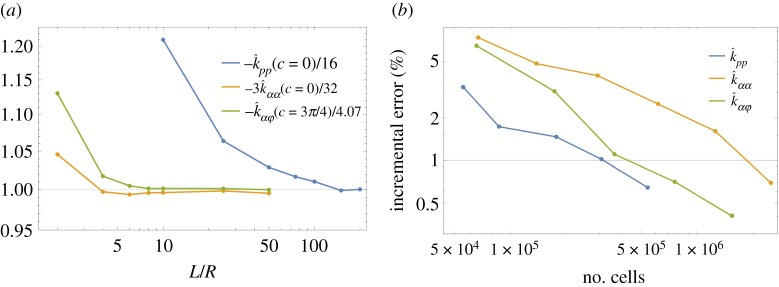
Numerical convergence of the hydrodynamic coefficients in (3.13) for a circular shell. (a) Convergence with respect to the size L of the bounding box Ω; k^pp(c=0) and kαα(c = 0) have been scaled with respect to their analytical values, while k^αφ is scaled with respect to its numerical value when L = 200R. (b) Convergence with respect to the number of FE cells for L = 100 R.